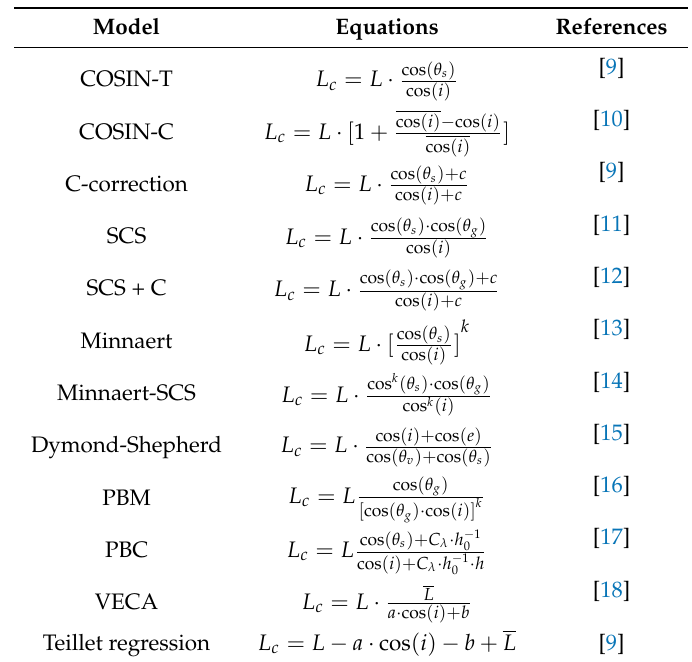
Table 1. Overview of the twelve topographic correction